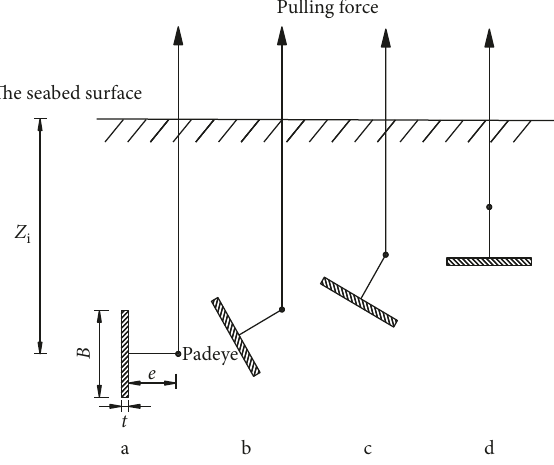
Figure 1: Diagram of the keying process of the plate